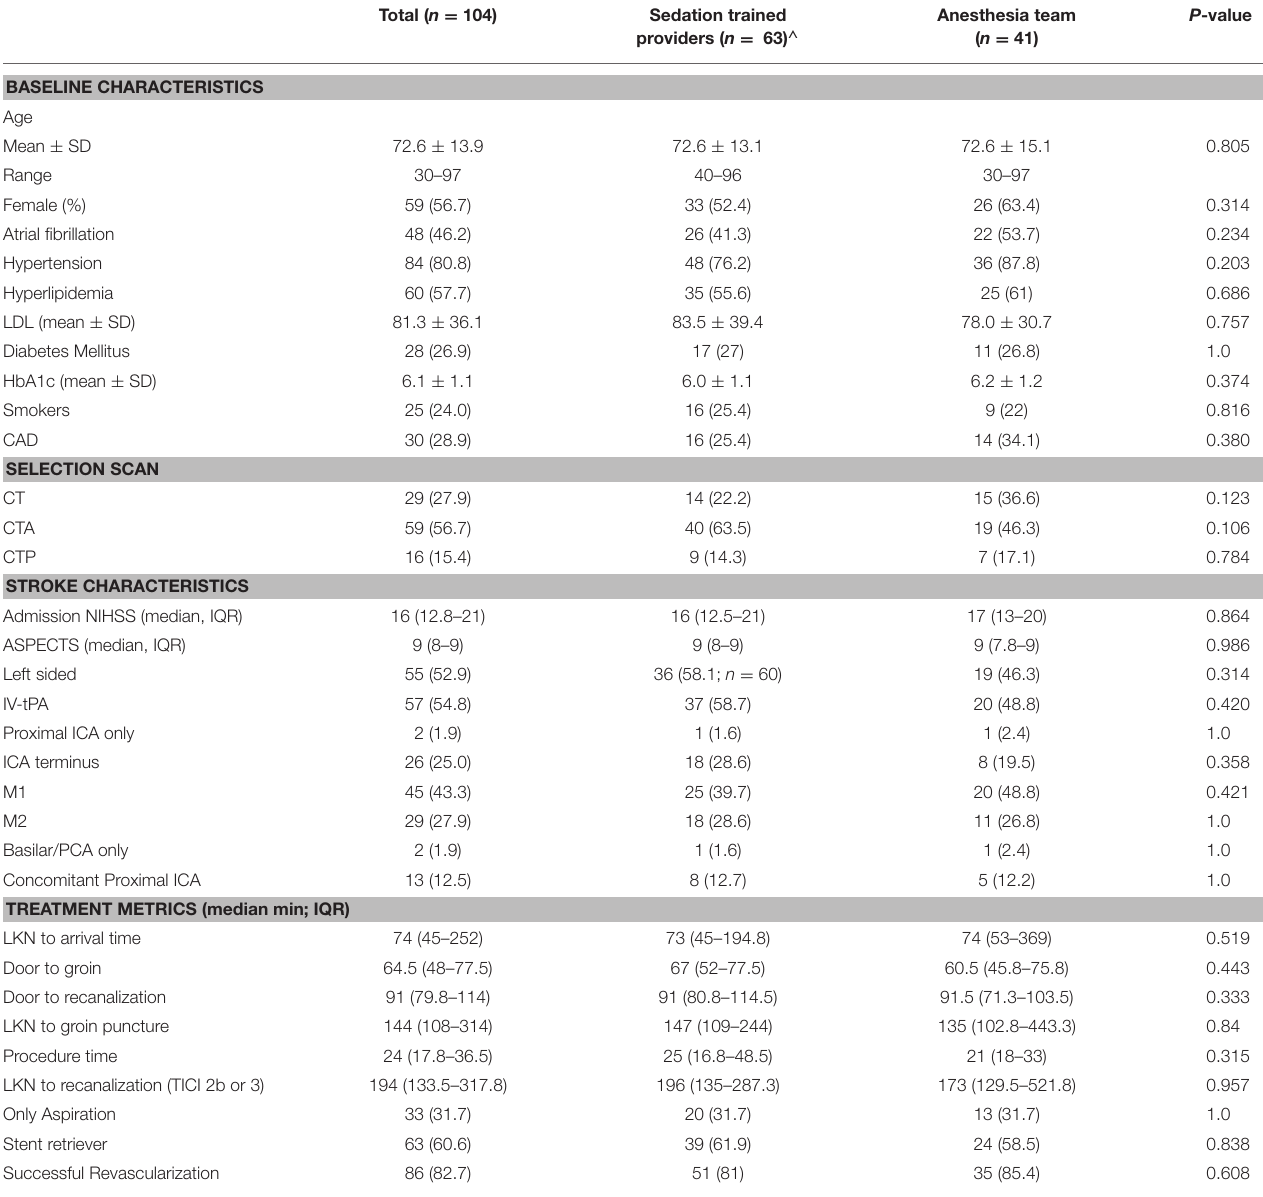
TABLE 1 | Baseline demographics, stroke characteristics, and procedural time metrics. Total ( n = 104) Sedation trained providers ( n = 63)